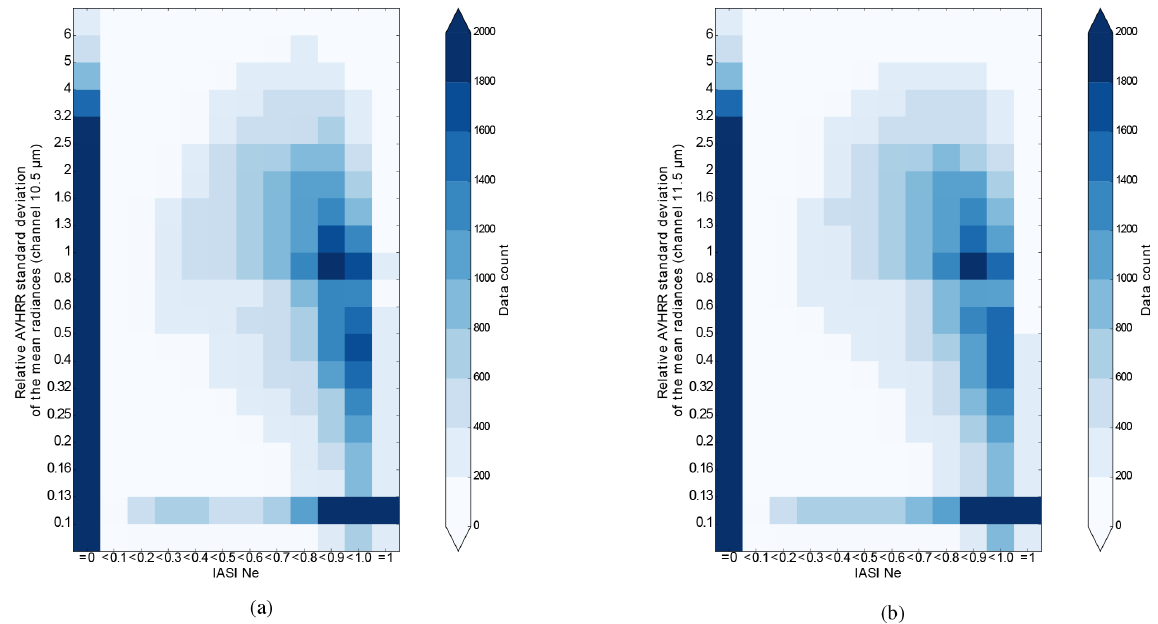
Figure 2. Density plot (number of observations) of the values of effective cloud fraction retrieved from IASI by a CO 2 -slicing algorithm (on the abscissa) with respect to the relative cluster standard deviation of the mean radiances (%, on the y axis) for intercluster homogeneity for (a) the AVHRR IR channel (10.5µm) and (b) the AVHRR IR channel (11.5µm). Table 1. Summary of the criteria for homogeneous IASI observation selection used in this study. Methods Literature AVHRR channels Homogeneity criteria Test on background simulation used in observation space M2013 Martinet et al. (2013) 11.5µm intra- and intercluster distance with observation E2014 Eresmaa (2014) 10.8 and 11.5µm intercluster average distance with each cluster Obs_HOM 10.8 and 11.5µm intercluster no COMPR 10.8 and 11.5µm intercluster average distance with each